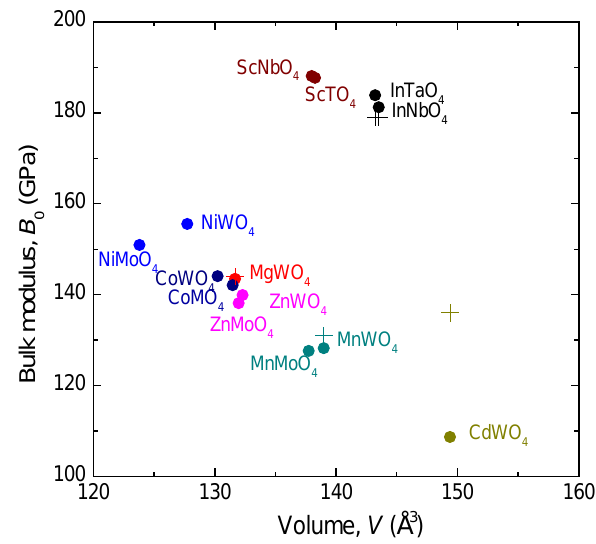
Figure 3. Volume change of the bulk modulus B 0 of all known compounds with a wolframite-type structure. Crosses (+) represent experimental results. Circles are the estimated B 0 considering the WO 6 , MoO 6 , TaO 6 , and NbO 6 as rigid units and the following dependence with the A–O distances: B 0 = 610· Z / d A–O 3 in the case of tantalates and niobates and B 0 = 661· Z / d A–O 3 in the case of tungstates and molybdates. Different colors are used for different compounds, the same color being used for the compound name.